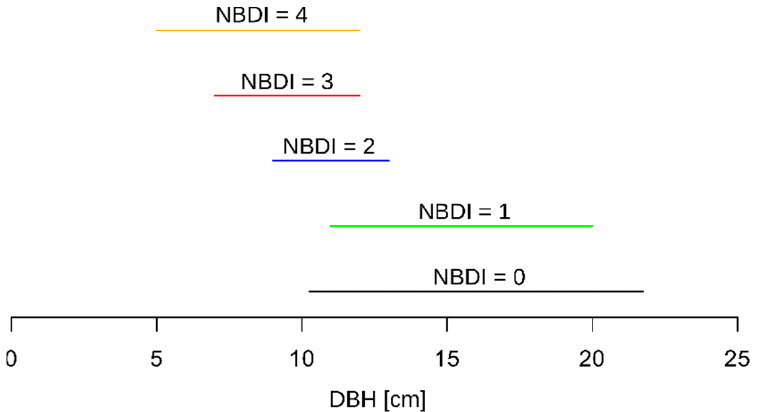
Figure 4. The 95% confidence intervals for the DBH means for trees with {0..4} instances of bark stripping damage.